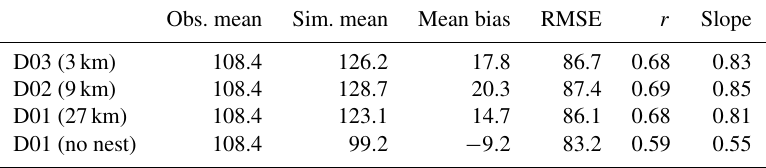
Table 4. Impacts of model resolution on simulation of hourly PM 2 . 5 concentrations (in µgm − 3 ) in Beijing over 12–31 October 2014. Obs.